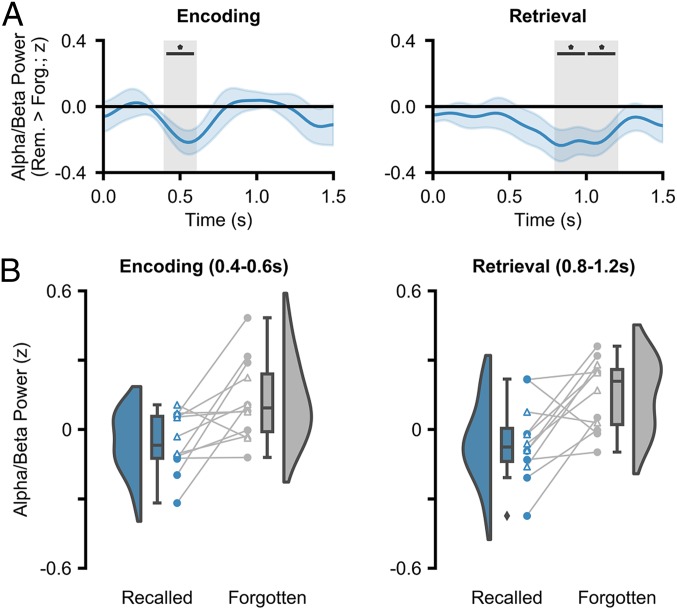
ATL alpha/beta activity during encoding and retrieval. (A) Time series of memory-related alpha/beta power for encoding and retrieval. In both cases, decreases in alpha/beta power relate to greater memory (*Pfdr < 0.05). (B) Raincloud plots depicting the difference in alpha/beta power between remembered and forgotten items. Colored circles represent participants who took part in experiment 1. Uncolored triangles represent participants who took part in experiment 2.